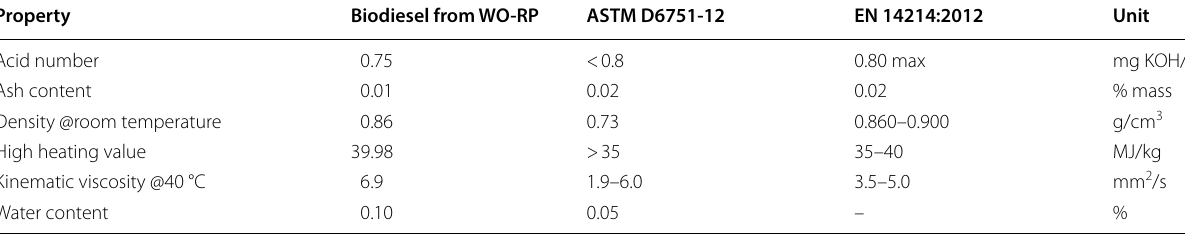
Table 9 Characteristic of biodiesel compared to ASTM and EN standards Property Biodiesel from